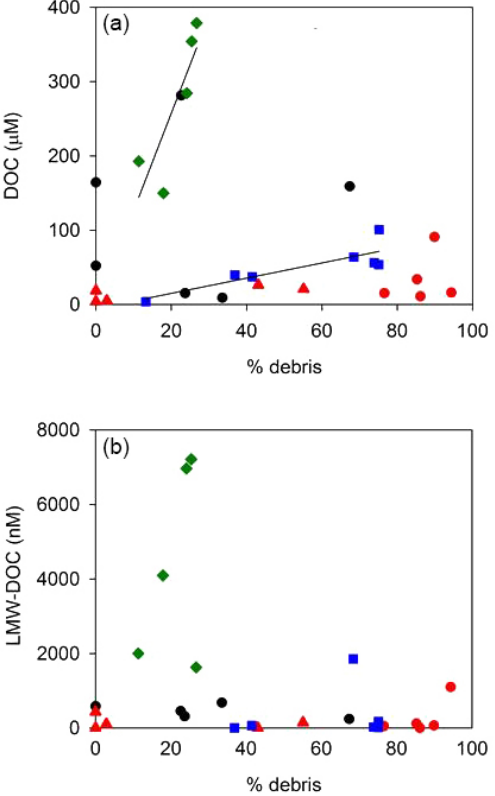
Figure 1. Associations between (a) DOC and debris concentra- tion, and (b) LMW-DOC and debris concentration. Engabreen sam- ples are given in black, Finsterwalderbreen in red (FDB (dispersed banded ice) as triangles and FSB (solid banded ice) as circles), Rus- sell Glacier in blue, and Joyce Glacier in green. P< 0 . 05 for all re- gression equations, only significant correlations are